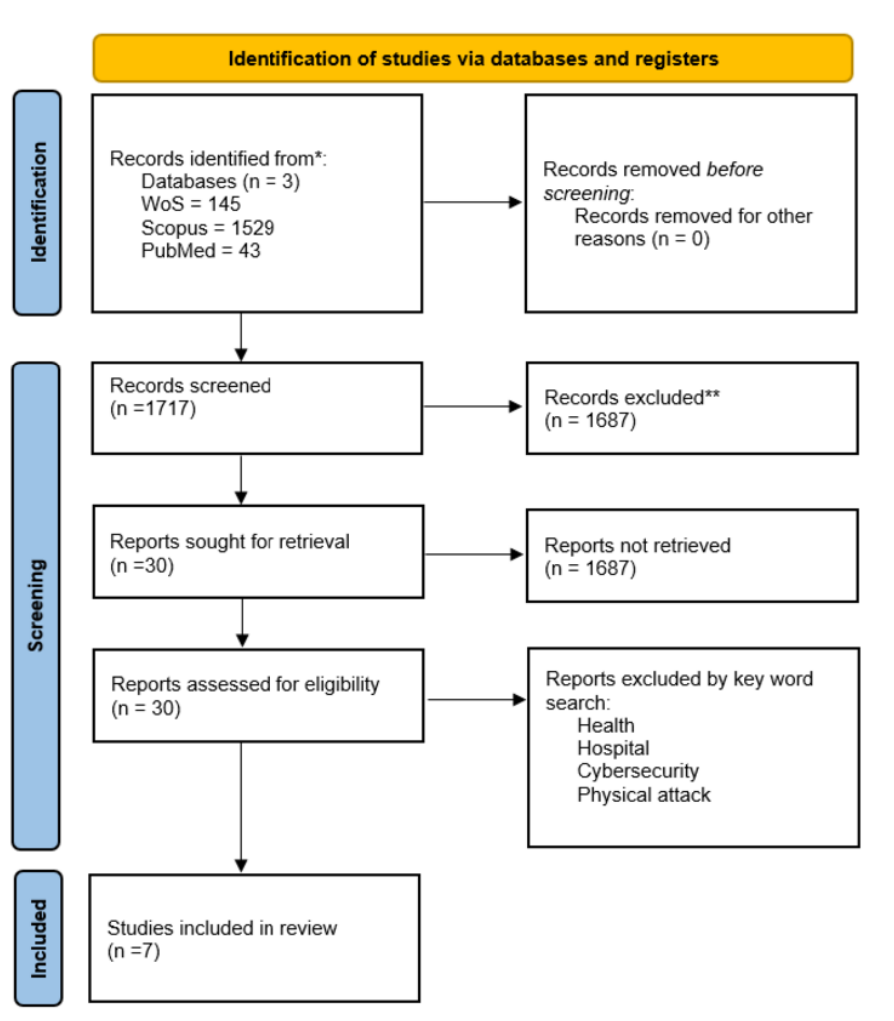
Figure 2. PRISMA flowchart. * The number of records identified from each database. ** Records excluded from the database based on search criteria.